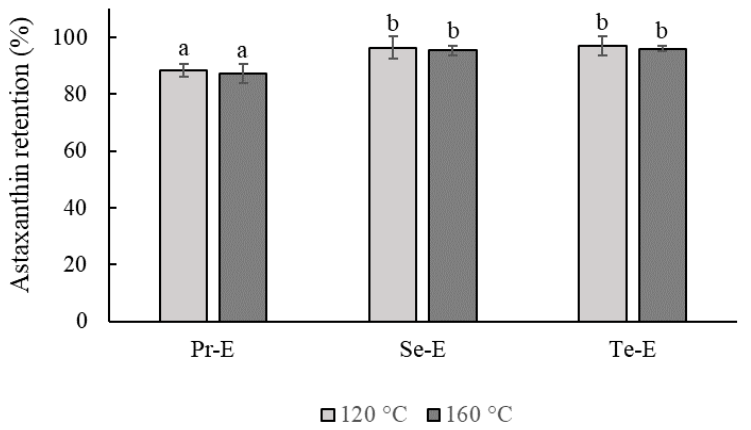
Figure 7. Effect of the inlet temperature of the dried air on the retention of astaxanthin of Pr-E, Se-E, and Te-E during the spray-drying process. Different letters represent significant differences ( p < 0.05) in the retention of astaxanthin.